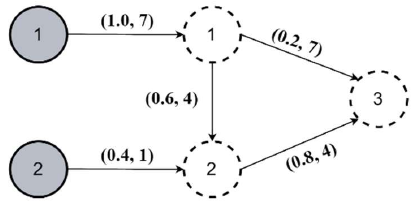
Figure 6. Goods distribution network N1.